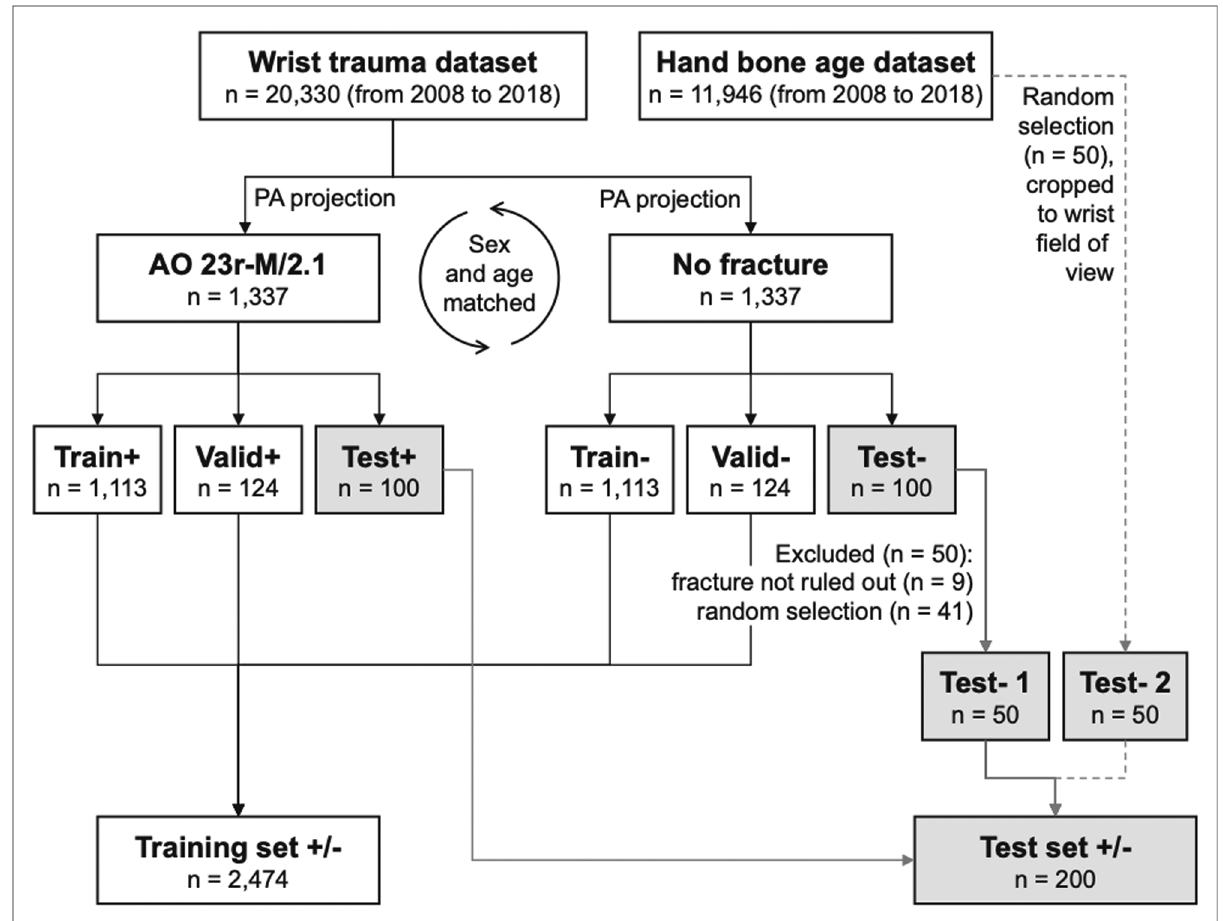
FIGURE 1 Flowchart depicting the datasets and the performed steps of obtaining training, validation, and testing